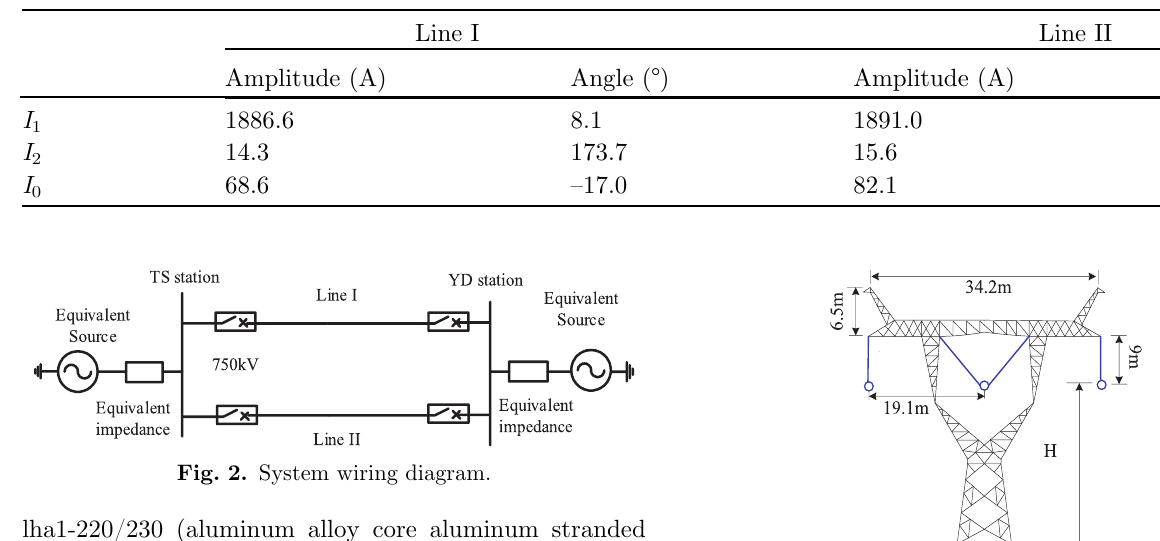
Table 2. The amplitude and phase angle of the sequence component of the line current on the YD side (measured result).